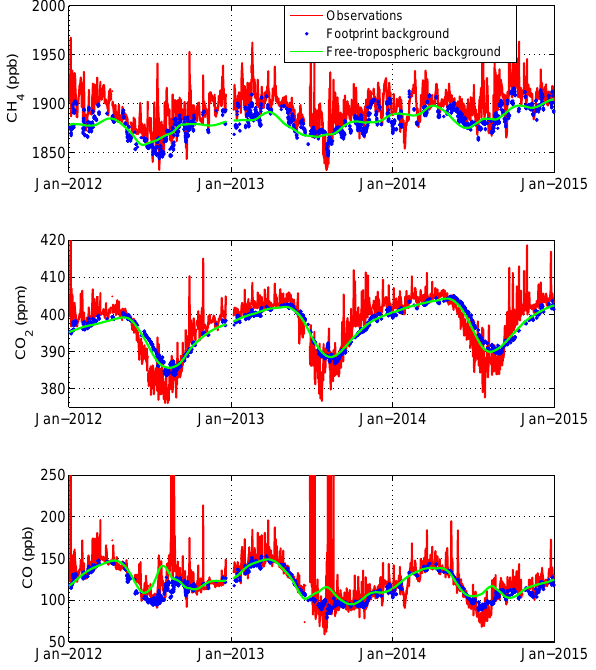
Figure 5. Time series of hourly average observed mole fractions (red) and background mole fractions (blue), 13:00 to 18:00 local standard time (LST) only for CH 4 (top), CO 2 (center), and CO (lower) at the CARVE tower. Observations are indicated by solid red lines, while the background mole fractions used for this anal- ysis are shown in blue dots and are derived using the particle tra- jectories from the STILT model and an empirical Pacific boundary curtain, described in the text. Gaps in the blue dots appear when the background could not be calculated using the model because the air masses did not enter the domain from the west (as described in Sect. 3.3). The green line represents the value of the same Pacific boundary curtain at the site latitude (65 ◦ N) at 3500ma.s.l., i.e., the free troposphere. The vertical scale for CO has been